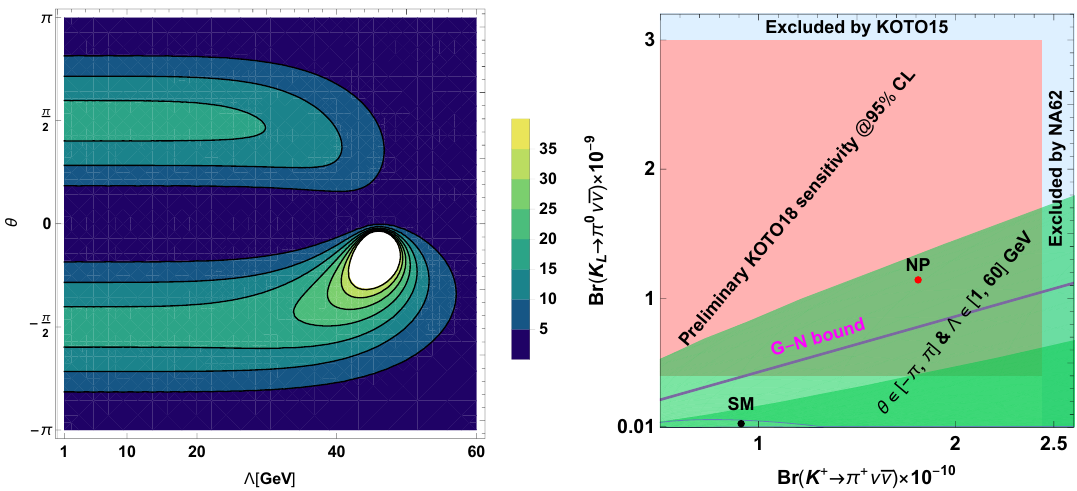
Figure 1 . Left panel: contours of B ( K L ! (cid:25) 0 (cid:23) (cid:22) (cid:23) ) = B ( K + ! (cid:25) + (cid:23) (cid:22) (cid:23) ) values on the (cid:3)- (cid:18) plane from the (cid:1) I = 1 = 2 ; 3 = 2 operators in the example NP model discussed in the text. Right panel: the branching- fraction predictions of the model compared to an interpretation [11] of recent KOTO results [1, 5] and to the latest NA62 limit [6], and the red dot labeled NP corresponds to ((cid:3) ; (cid:18) ) = (39 GeV ; (cid:0) (cid:25)= 4) in this